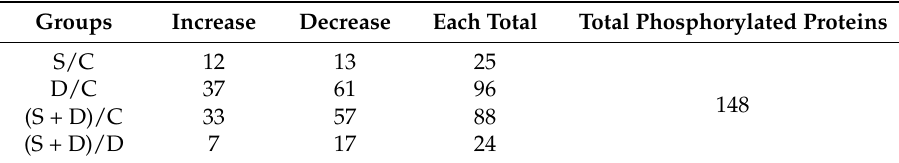
Table 1. Number of differentially expressed significant phosphorylated proteins in the leaves of wheat seedlings.